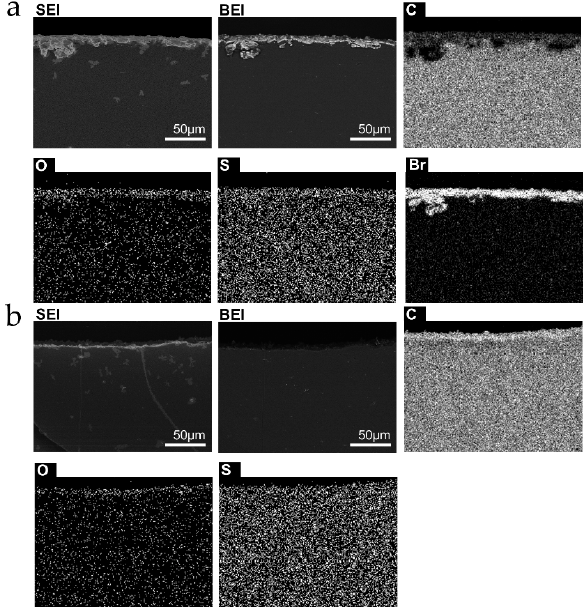
Figure 6. Micrographs and elemental distribution maps of cut surfaces normal to the tubing length. ( a ) outer surface; ( b ) inner surface from sample L. Sample S. The scale bars in the SEI and BEI micrographs apply to the other images from the same area.